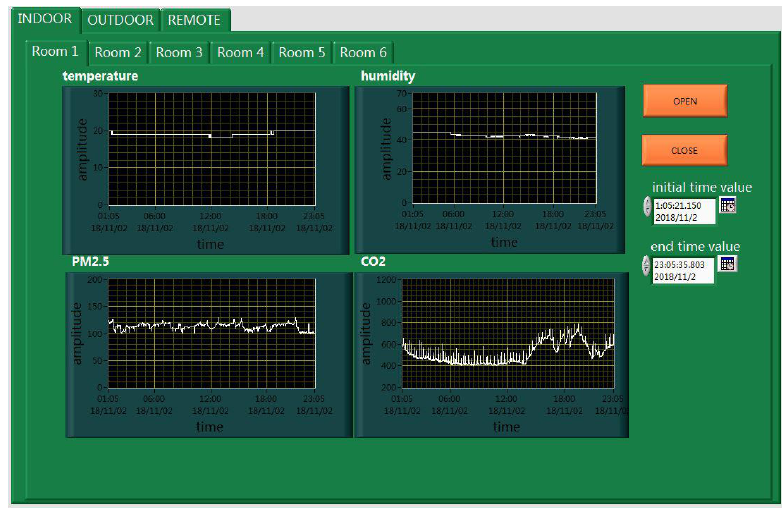
Figure 18. The “HISTORY” menu.